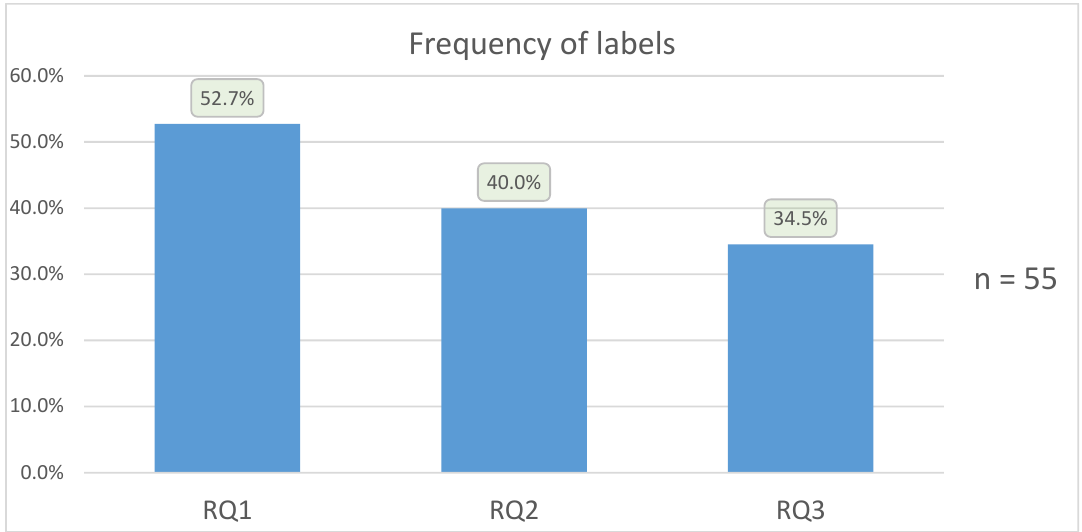
Figure 3. Number of primary studies providing answers to particular research questions (n — selected primary studies) (source: own study).